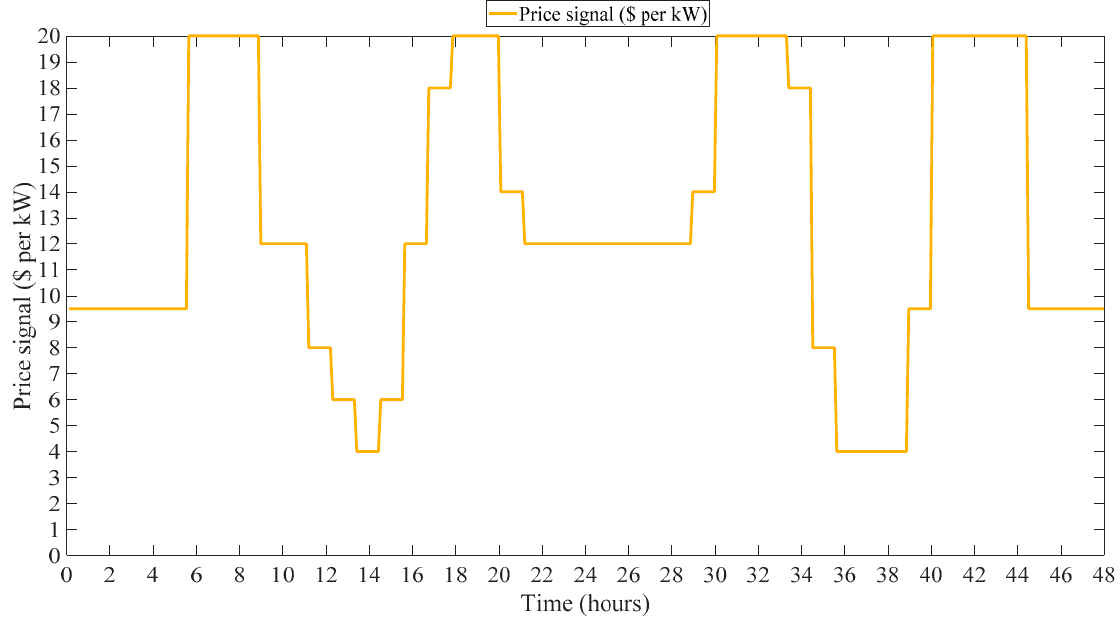
Figure 10. Example of dynamic price signal considered.